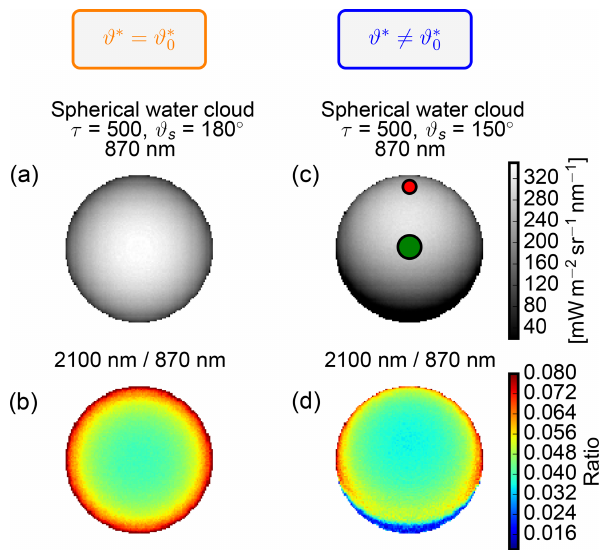
= 30 ◦ . The green and red dots mark viewing configurations shown 0